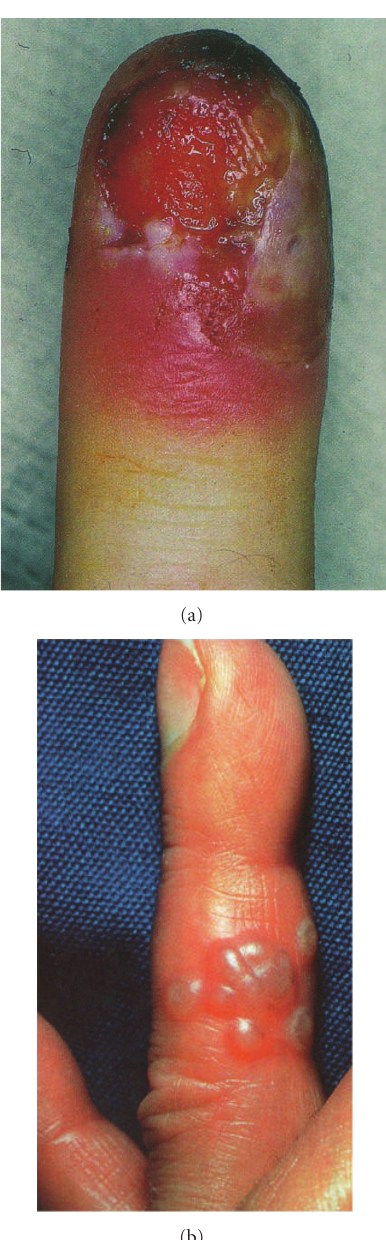
Figure 13: Herpes simplex virus. (a) patient with HIV [9, page 813]; (b) deep-seated blisters [4, page